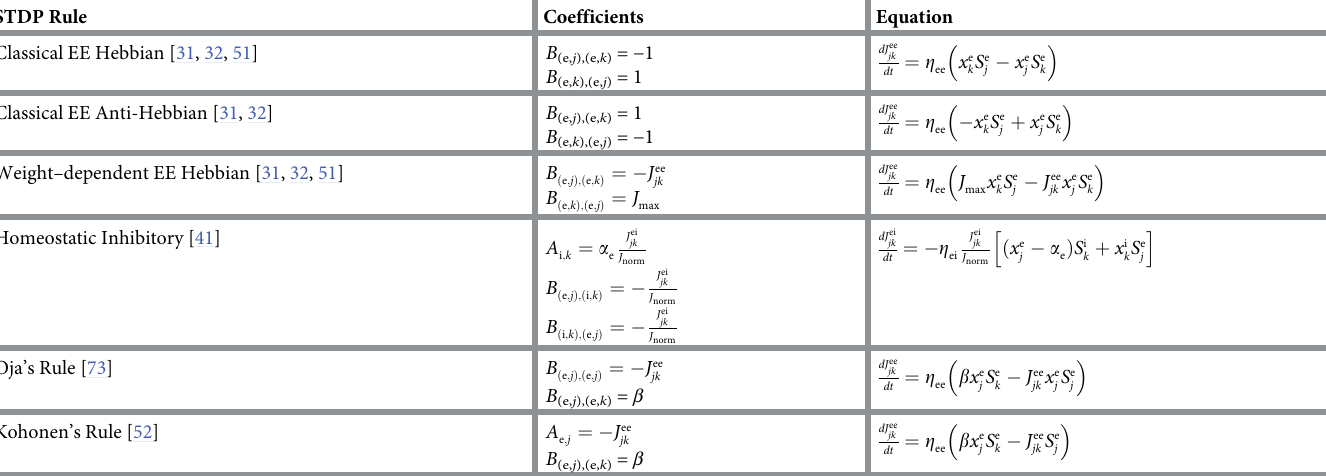
Table 1. Examples of STDP rules. A number of different plasticity rules can be obtained as special cases of the general form given in Eq